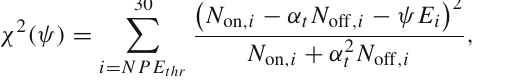
Fig. 26a are examples of reactor-on and reactor-off simu- lated datasets. Blue lines present the expected CE ν NS sig- nals. The CE ν NS signals are extracted by χ 2 minimization from NPE = N P E thr to NPE =